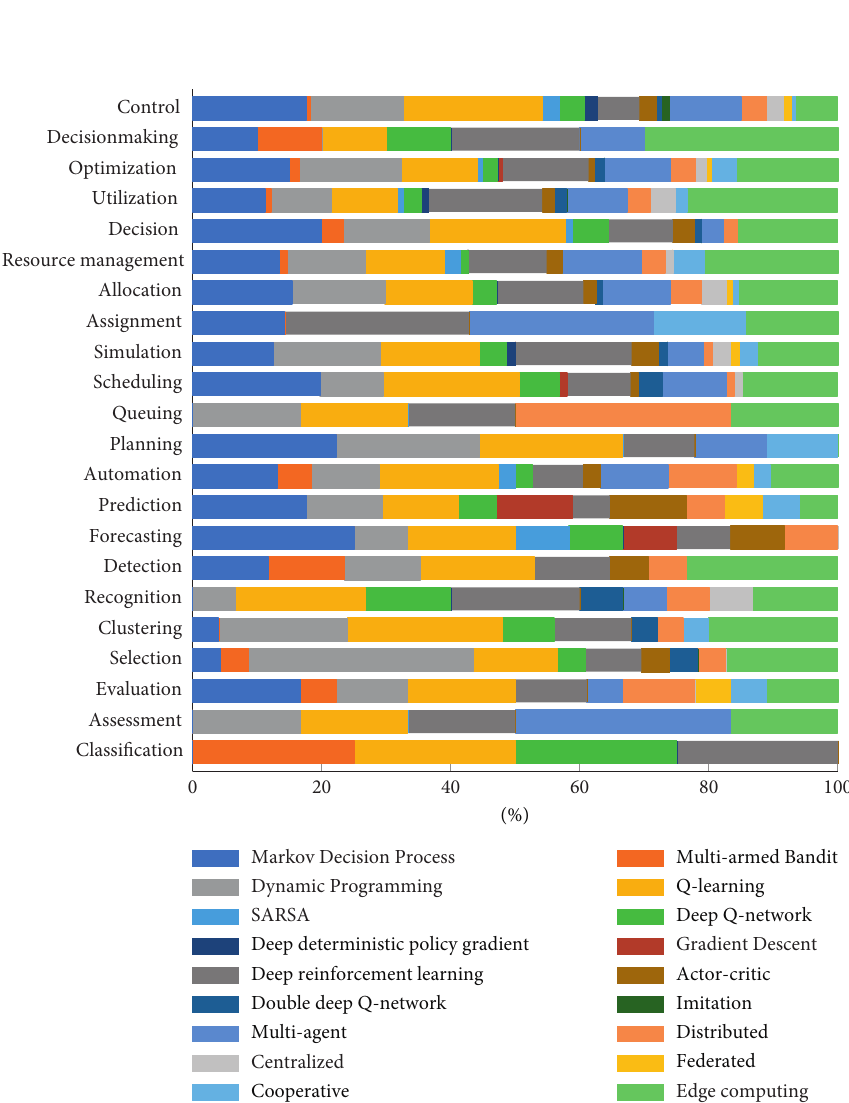
Figure 4: Distribution of RL methods by principal captured